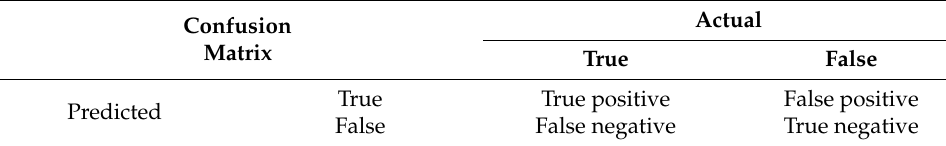
Table 4. The confusion matrix.